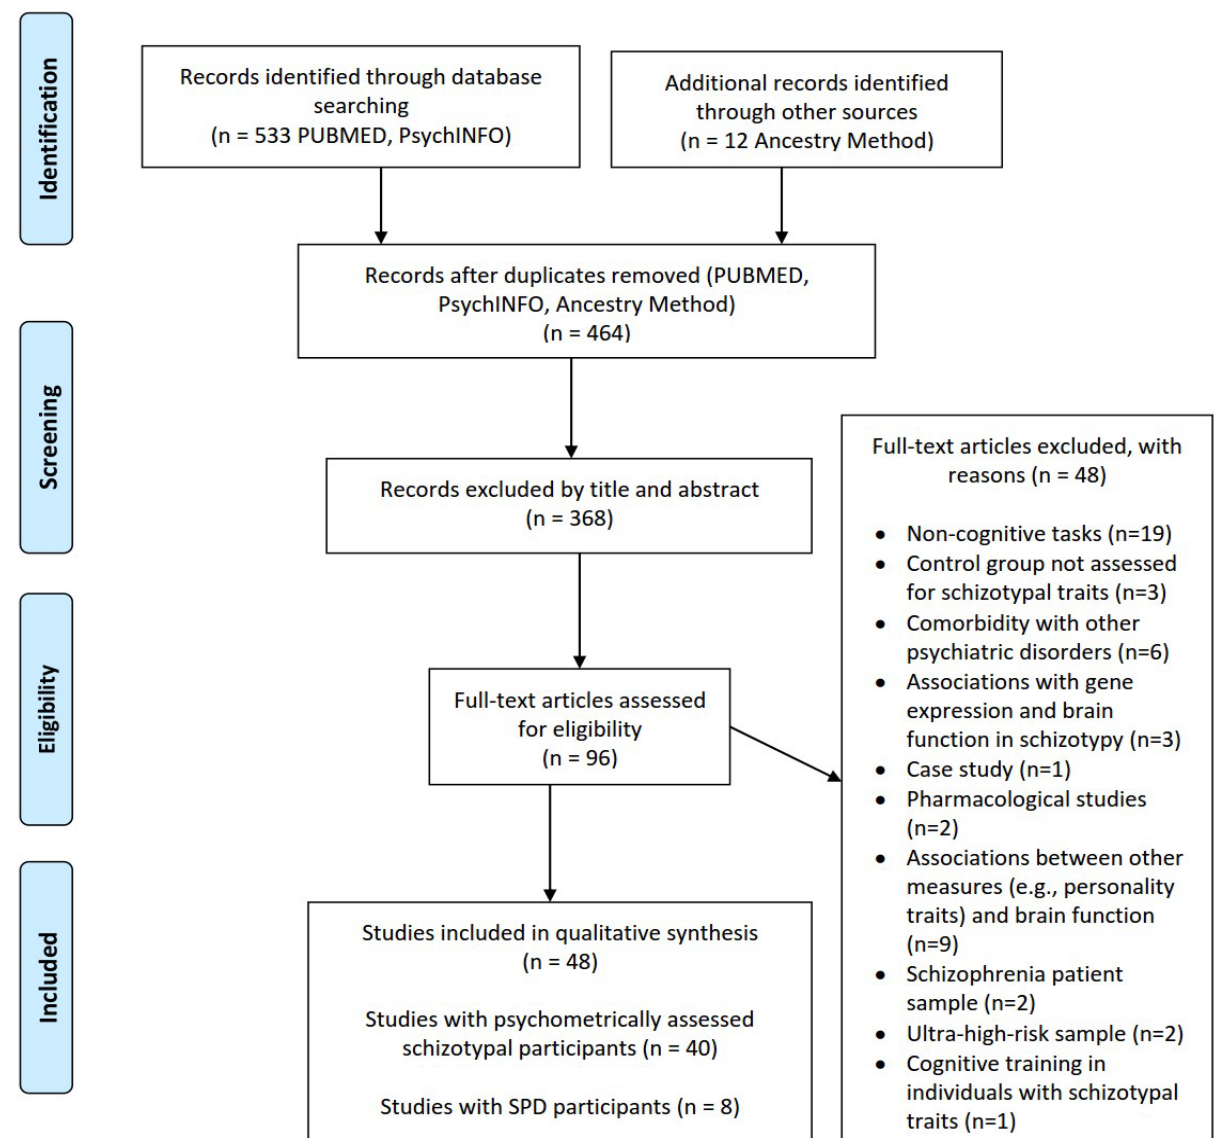
Figure 3. Flowchart of information on the selection of studies.